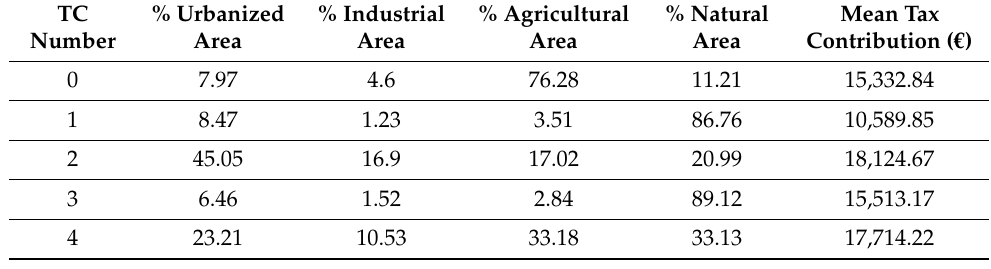
Table 1. Composition of the different territorial clustering classes (TC) with relation to the five considered attributes.